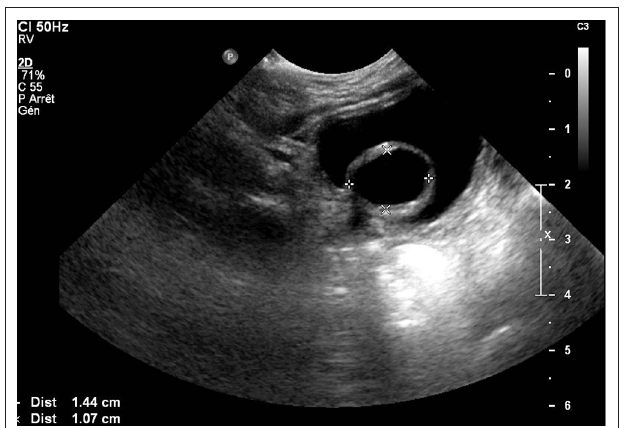
FIGURE 4 | US scan of obstructive ureterocele in a duplex system.